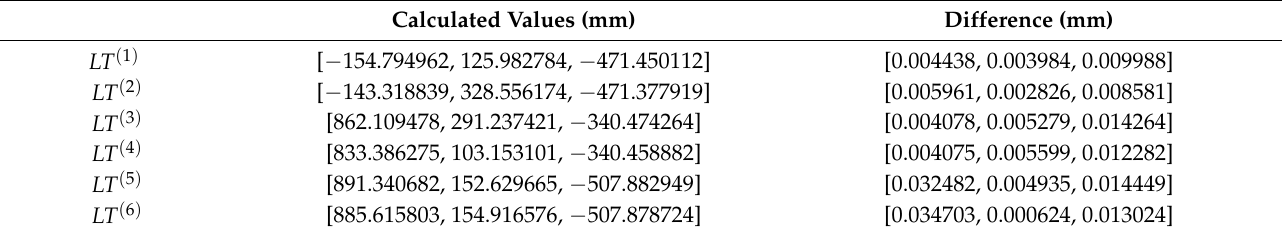
Table 7. Calculated LT positions for Case A with function